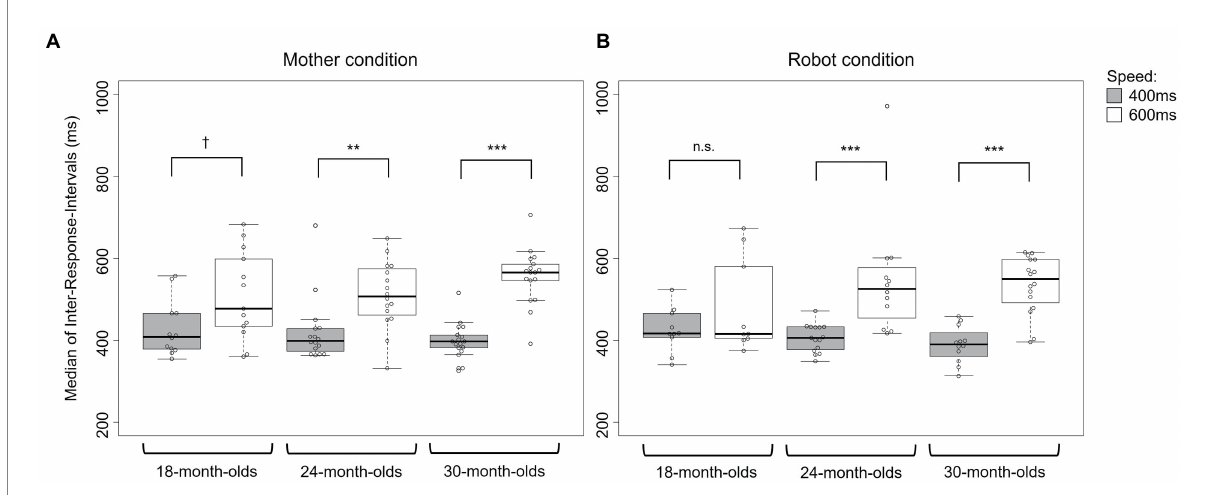
FIGURE 2 Median of inter-response intervals (IRIs) depending on the two speed conditions under (A) , mother condition and (B) , robot